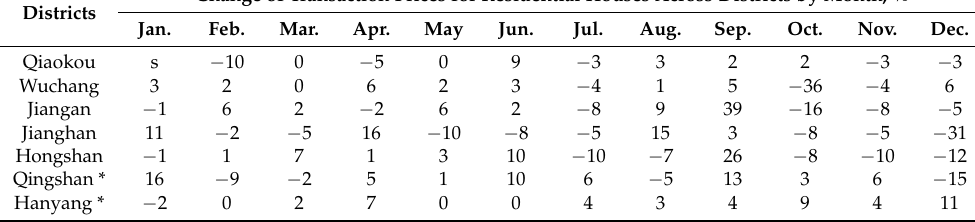
Table 6. Monthly percentage change of transaction prices for housing in central districts of Wuhan in 2016.